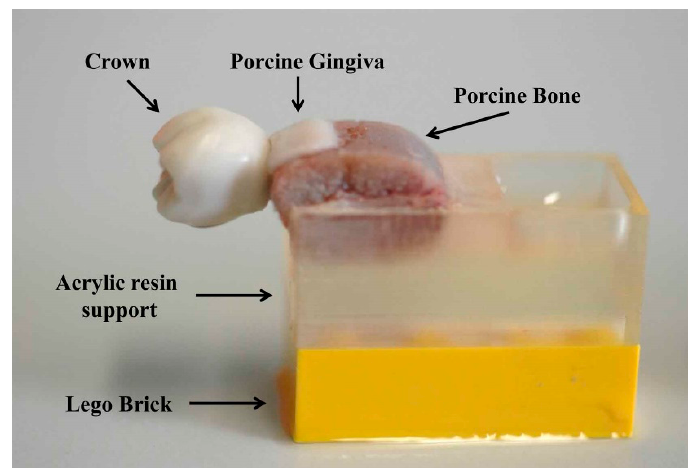
Figure 1. Bone sample with gingiva attached, a dental implant, and a superstructure.